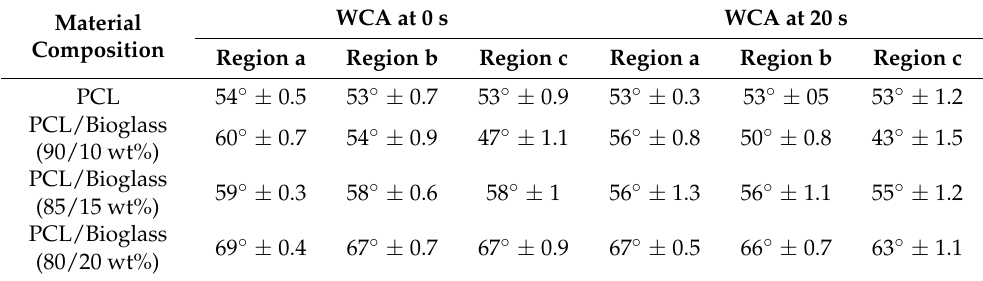
Table 2. The WCA results of the different regions of the scaffolds and the different time points.